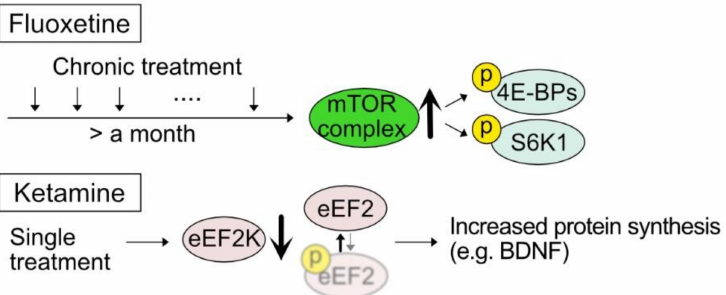
Figure 2. Translational control in antidepressant action. Antidepressant treatment regulates translation through the posttranslational modifications of the components in translation regulatory pathway. Chronic treatment of fluoxetine triggers the activation of the mTOR signaling pathway (upward arrow) leading to phosphorylation of 4E-BPs and S6K1. A single treatment of a subanesthetic dose of ketamine suppresses eEF2K activity (downward arrow) to increase protein synthesis, including BDNF, through dephosphorylation of